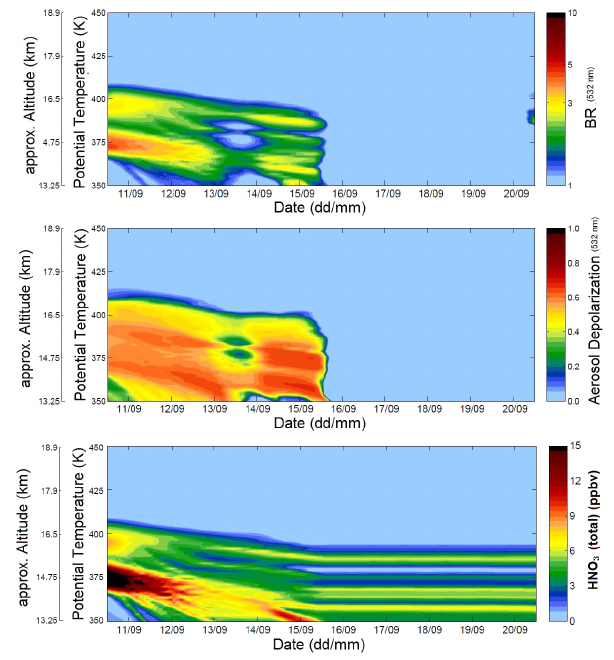
Figure 5. Profiles of backscatter ratio (upper panel), aerosol depo- larization ratio (middle panel) and total HNO 3 (lower panel) start- ing from the observations taken on 10 September 2008, and evolv- ing according to the microphysical